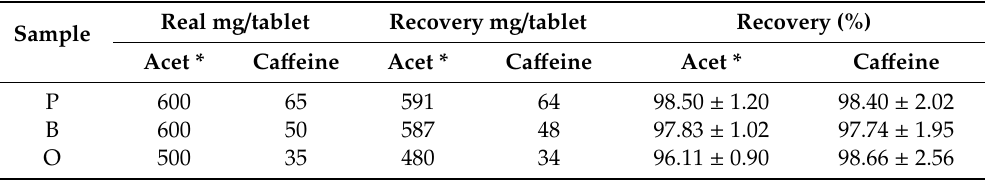
Figure 10. DPV voltammogram sample P ( a ), sample B ( b ) and sample O, ( c ) Each sample was dissolved in PB pH 2, measured both by GCE-M221-Fe 3 O 4 and unmodified GCE as the working electrode. Table 6. Recovery of acetaminophen and ca ff eine from P, B, and O samples dissolved in PB pH 2, determined by DPV with GCE-M221-Fe 3 O 4 as the working electrode. Real mg / tablet Recovery mg / Sample